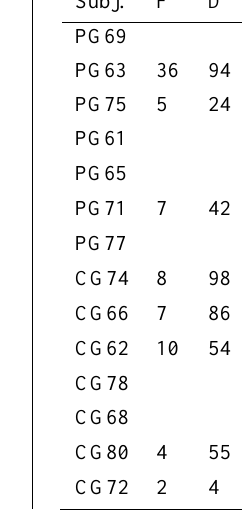
Table 2. Pupil dilation event classification. F = the number of candidate peaks that did not correspond to a hazard situation but were misclassified as such an event (false positives); D = the number of candidate peaks before the classification step. Subject descriptors indicate the patient groups of hemianopia (PH) and glaucoma (PG) as well as their respective control groups (CH/CG) Subj.